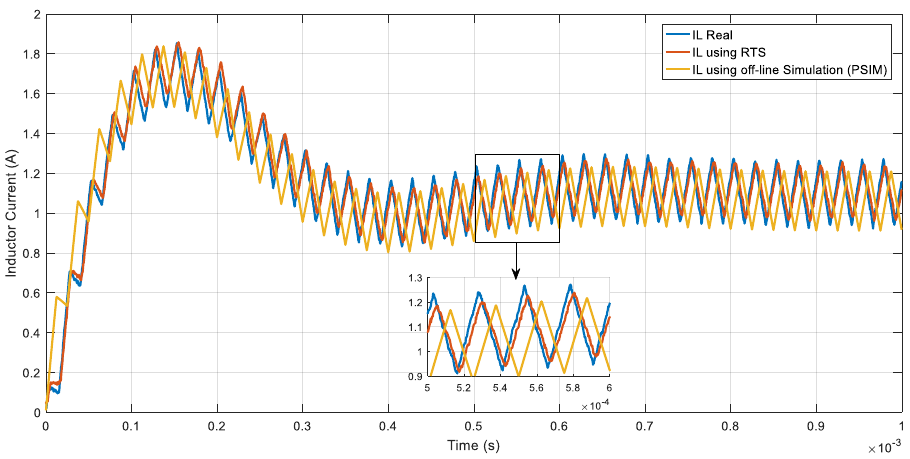
Figure 14. Inductor current of the real buck converter: real-time simulation and PSIM.